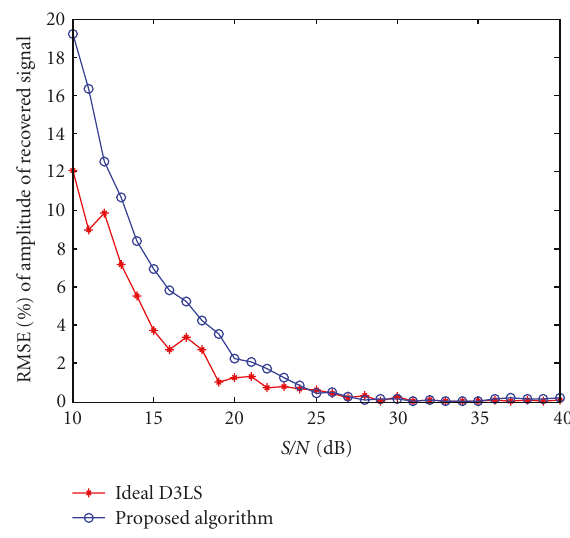
Figure 6: RMSE of the recovered amplitude versus the